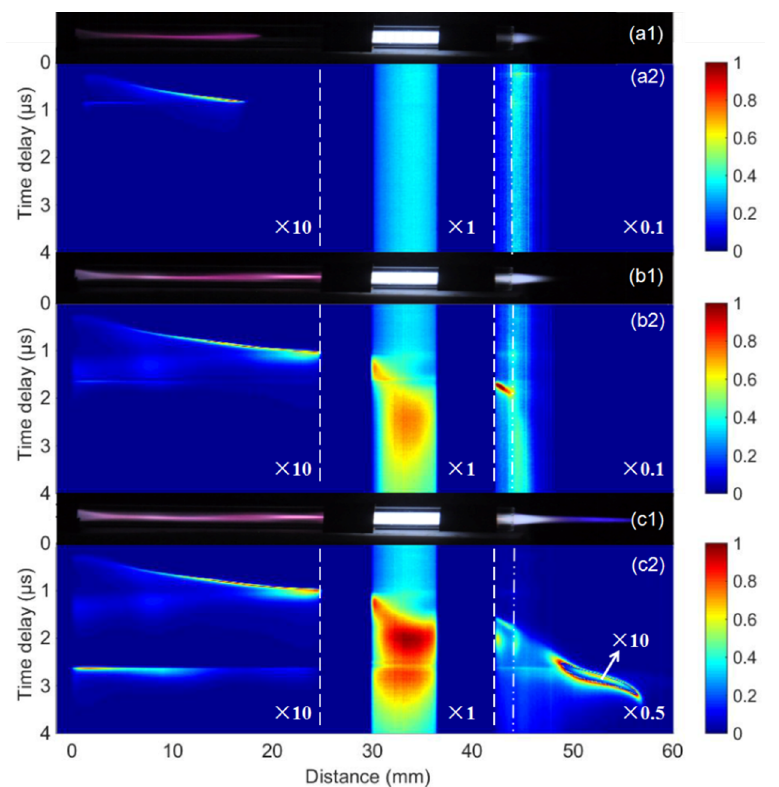
Figure 2. Discharge appearance of pulsed discharge, RF discharge, and plasma plume with the pulsed voltage duration of ( a1 ) 0.6 μ s, ( b1 ) 1.4 μ s, and ( c1 ) 2.4 μ s, and corresponding temporal evolution of discharge spatial profiles as shown in ( a2 , b2 , c2 ).